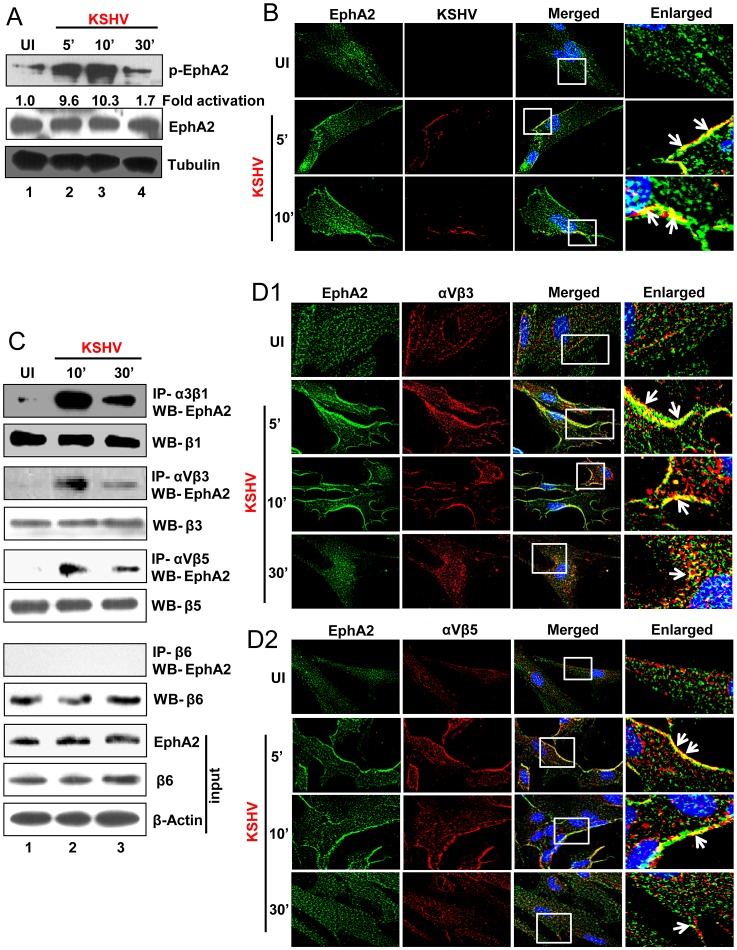
EphA2 is activated and associated with entry receptors early during KSHV infection.(A) Serum-starved (8 h) HFF cells were either mock infected (UI) or infected with KSHV (30 DNA copies/cell) for the indicated time periods and subjected to Western blot analysis for phospho-EphA2 (Y594) (pEphA2). The blot was stripped and reprobed for total EphA2 and tubulin was used as loading control. (B) Serum starved HFF cells were either mock infected or infected with KSHV (30 DNA copies/cell) for 5 and 10 min and processed for immunofluorescence analysis using rabbit anti-EphA2 and mouse monoclonal anti-KSHV gpK8.1A antibodies for overnight at 4°C followed by staining with anti-rabbit Alexa 488 and anti-mouse Alexa 594 secondary antibodies. Representative 2D convoluted images are shown. The white boxes within the merged panels are shown as enlarged pictures and the white arrows represent colocalization of the indicated molecules. (C) Serum-starved HFF cells were left uninfected or infected with KSHV for the indicated periods of time and immunoprecipitated with anti-α3β1, αVβ3 or αVβ5 antibodies and analyzed for EphA2 by Western blot (first, third and fifth panels). These blots were stripped and reprobed for total β1, β3 and β5 integrin subunits, respectively (second, fourth and sixth panels). For negative control, cell lysates from uninfected or KSHV infected HFF cells were immunoprecipitated with anti-β6 antibody and analyzed for EphA2 by western blotting (seventh panel). The blot was stripped and reprobed with total β6 antibodies (eighth panel). Whole cell lysates were subjected to western blot analysis for input expression of EphA2 (ninth panel) and β6 (tenth panel) and β-actin was used as loading control (eleventh panel). (D) Serum starved HFF cells were either left uninfected or infected with KSHV (30 DNA copies/cell) for 5, 10 and 30 min, washed and processed for immunofluorescence analysis. Cells were permeabilized, blocked with blocking reagents and incubated with (D1) rabbit anti-EphA2 and mouse anti-αVβ3 antibodies or (D2) rabbit anti-EphA2 and mouse anti-αVβ5 antibodies for 2 h at room temperature followed by staining with anti-rabbit Alexa fluor 488 or anti-mouse Alexa fluor 594. Representative 2D deconvoluted images are shown. The enlarged pictures represent boxed regions within the merged panels and the white arrows represent colocalization of the indicated molecules.